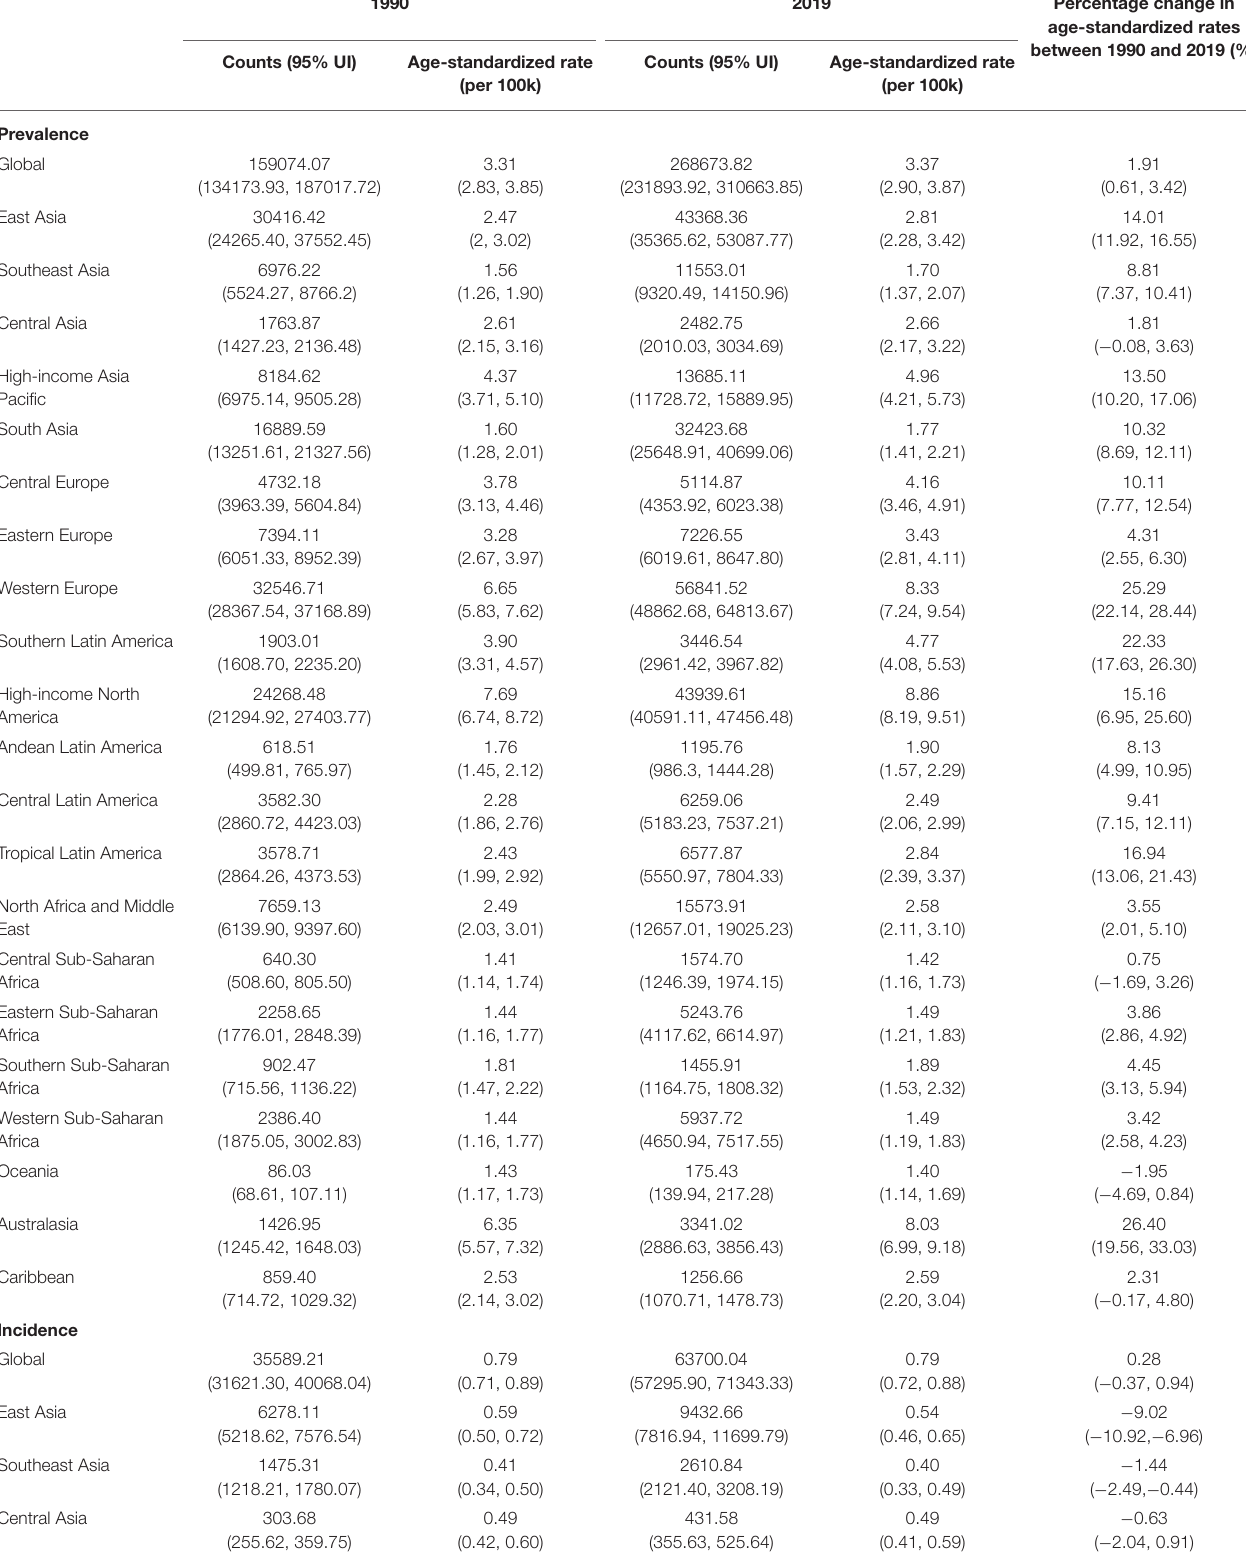
TABLE 1 | Prevalence, incidence, DALYs, YLD, YLL, and death of motor neuron diseases in counts and age-standardized rate for both sexes combined in 1990 and 2019, with percentage change between 1990 and 2019 by GBD